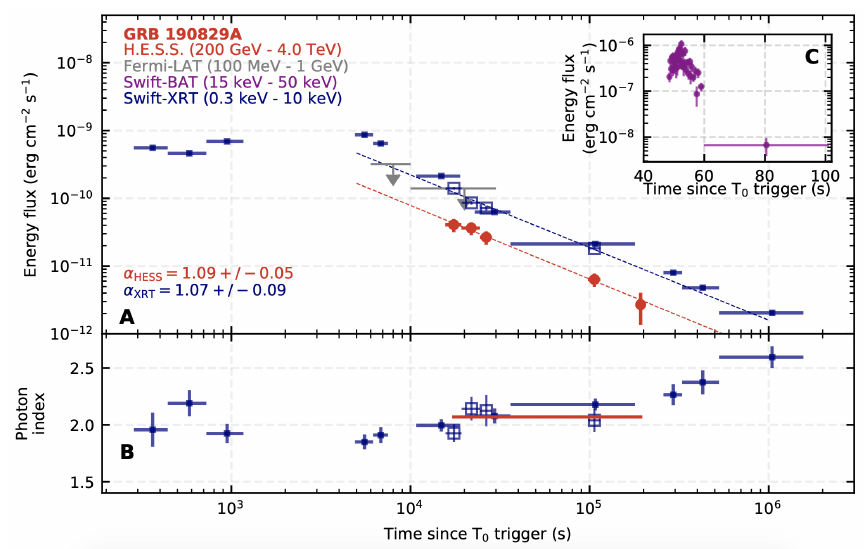
Figure 6. GRB 190829A detected by the H.E.S.S. Panel ( A ): X-ray (XRT, blue closed squares) and VHE gamma rays (the H.E.S.S., red circles) energy flux light curves. Upper limits on MeV γ -rays by LAT are also shown (grey arrows). The dashed blue line is the PL fit to the XRT temporal decay obtained by considering only the XRT data that were simultaneous with the H.E.S.S. observations (open squares). Panel ( B ): the corresponding intrinsic photon indices are shown. The H.E.S.S. intrinsic spectral index (red line) is the mean value of 2.07 ± 0.09 determined over all three nights of observation. Panel ( C ) shows the energy flux evolution of the prompt emission observed by the BAT. All error bars correspond to 1 σ uncertainty, and the LAT upper limits are at the 95% confidence